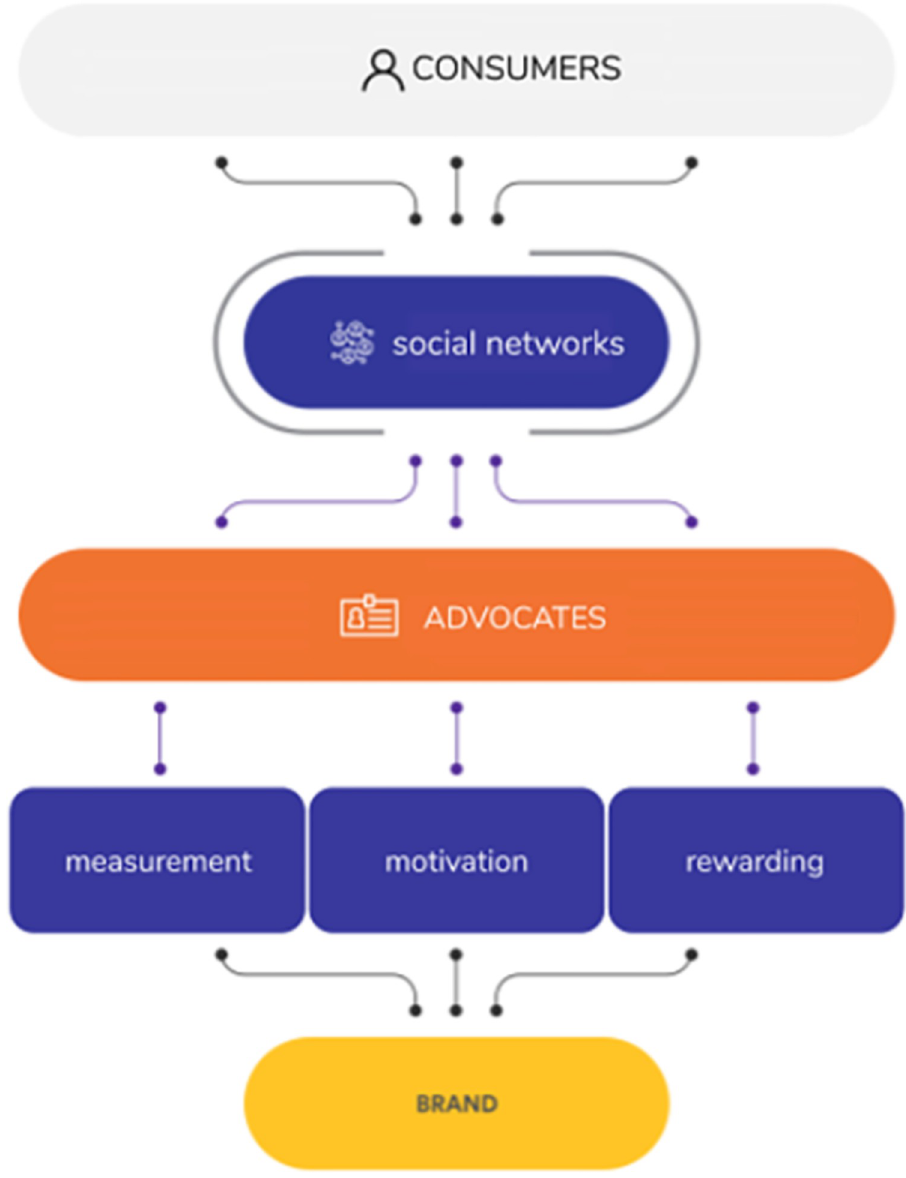
Fig 3. The work of the system for detecting of